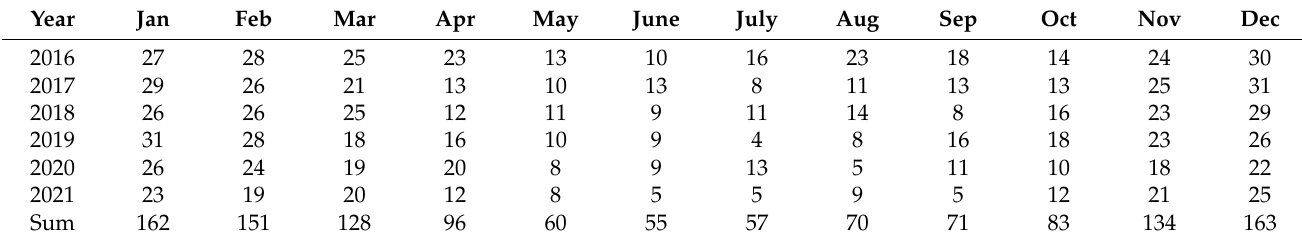
Table 2. The monthly haze events at Xianyang Airport from 2016 to